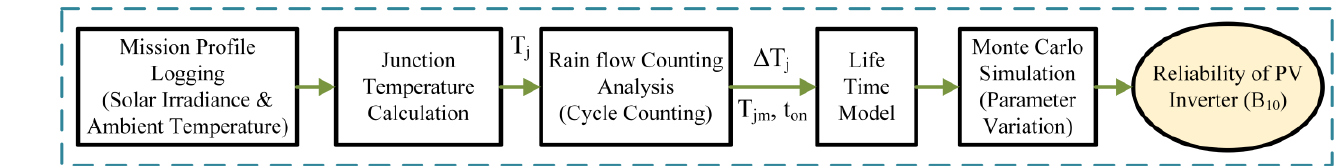
Figure 3. Flowchart for reliability analysis.